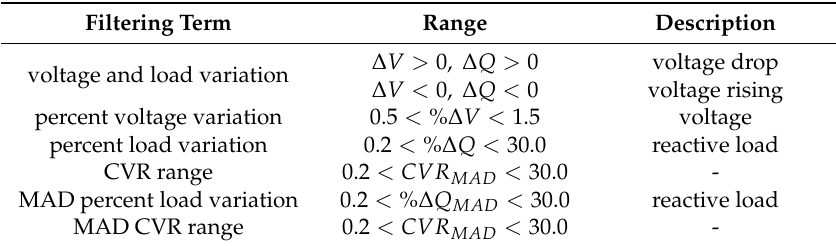
Table 6. Filtering conditions for estimating CVR factors of the reactive load.